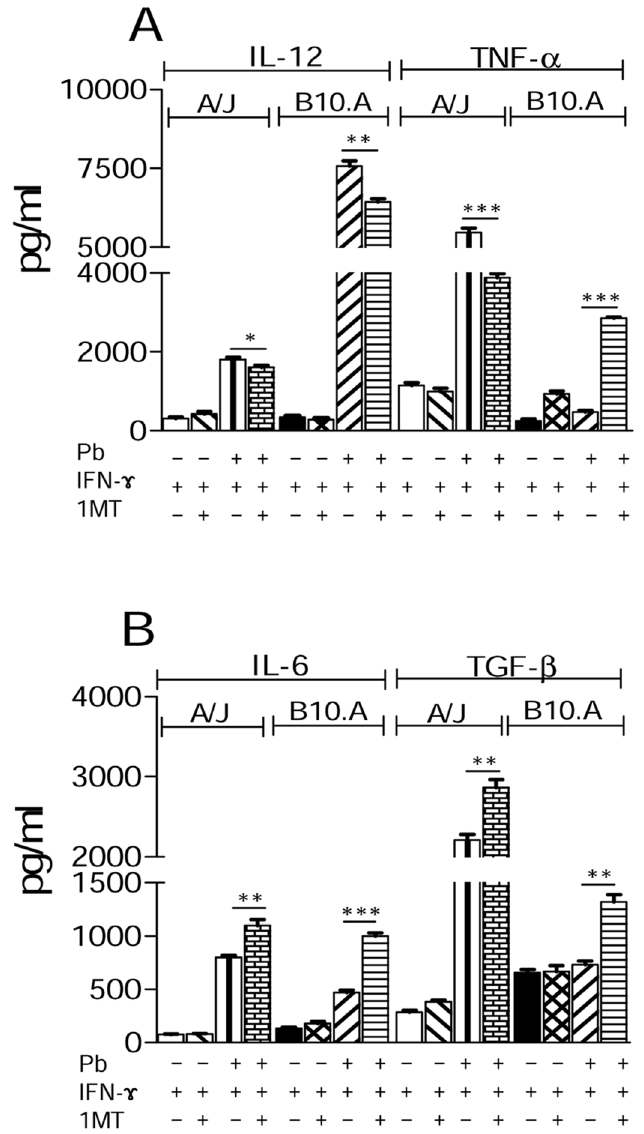
Figure 2. 1MT treatment reduces IL-12 and increases IL-6 and TGF- b production by A/J and B10.A macrophages. ( A, B ) IFN- c -primed and unprimed macrophages were treated with 1MT or left untreated and then cultivated for 48 h. Some cultures were infected with viable P. brasiliensis yeasts (1:25, fungus:macrophages ratio) for 48 h. Supernatants were removed and used for cytokine measurements by means of ELISA. Data are means 6 SEM of triplicate samples from three independent determinations (* p , 0.05, ** p , 0.01 and *** p , 0.001).